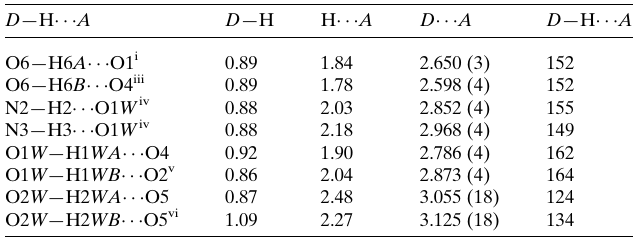
Table 2 Hydrogen-bond geometry (A˚ , (cid:4) ).